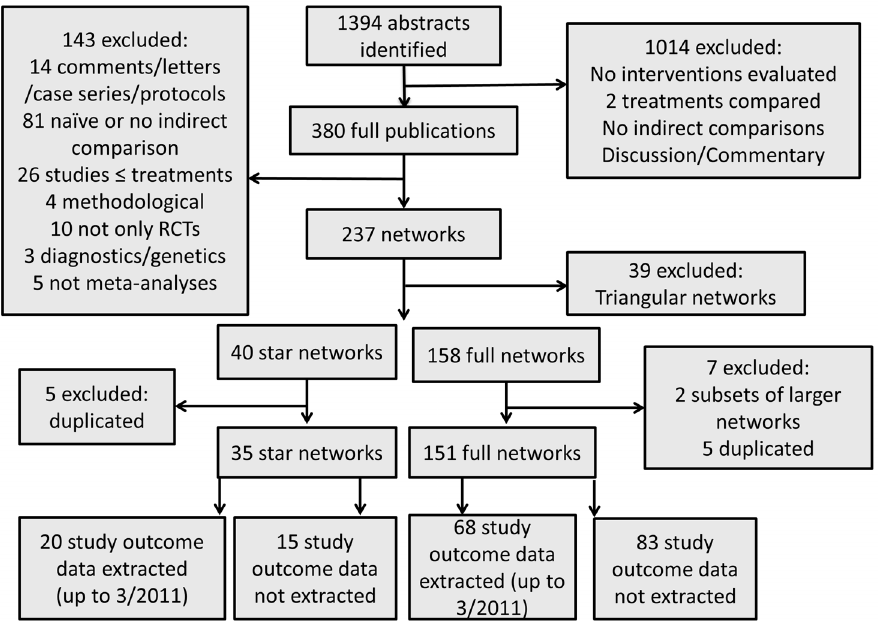
Figure 1. Flow chart of identified networks.